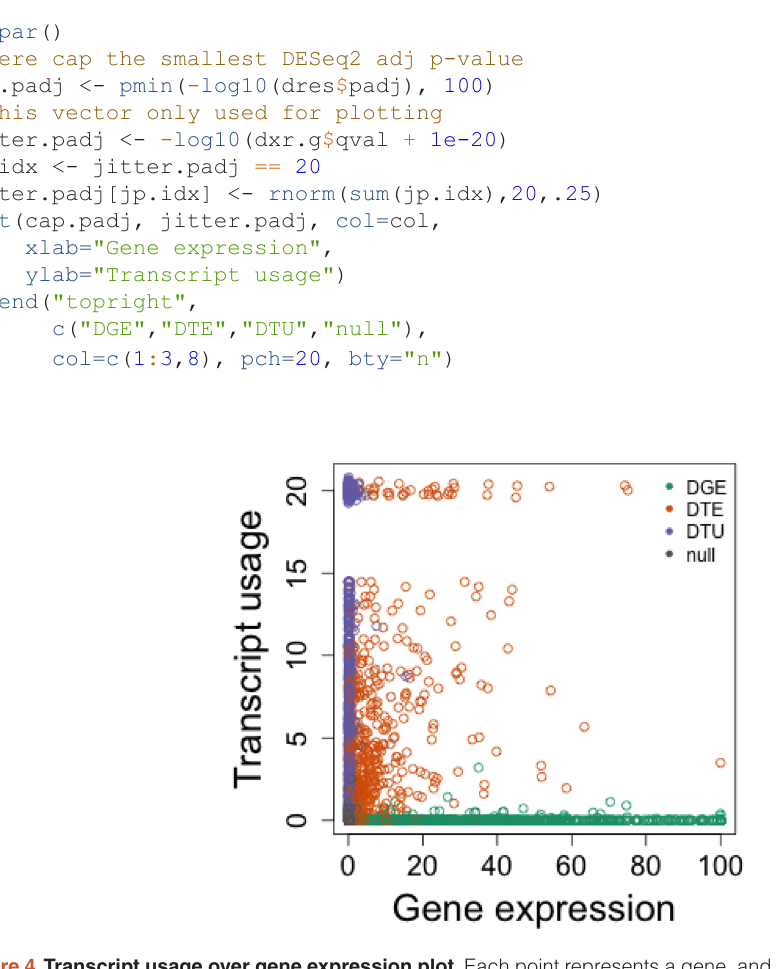
Figure 4. Transcript usage over gene expression plot. Each point represents a gene, and plotted are -log10 adjusted p-values for DEXSeq’s test of differential transcript usage (y-axis) and DESeq2’s test of differential gene expression (x-axis). Because we simulated the data we can color the genes according to their true